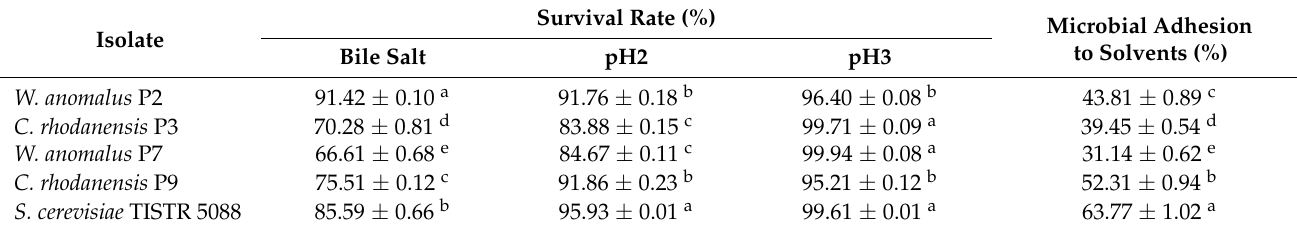
Table 1. Probiotic characteristics of four selected yeast strains.